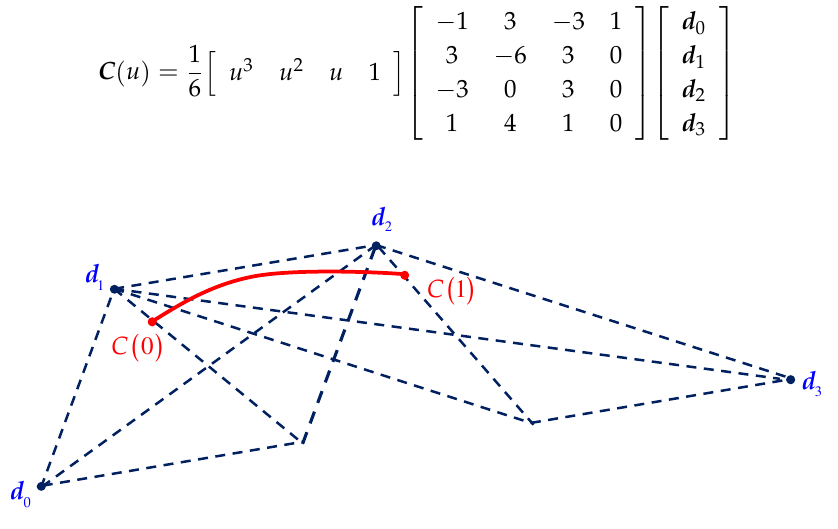
Figure 1. Schematic diagram of the parametric curve.